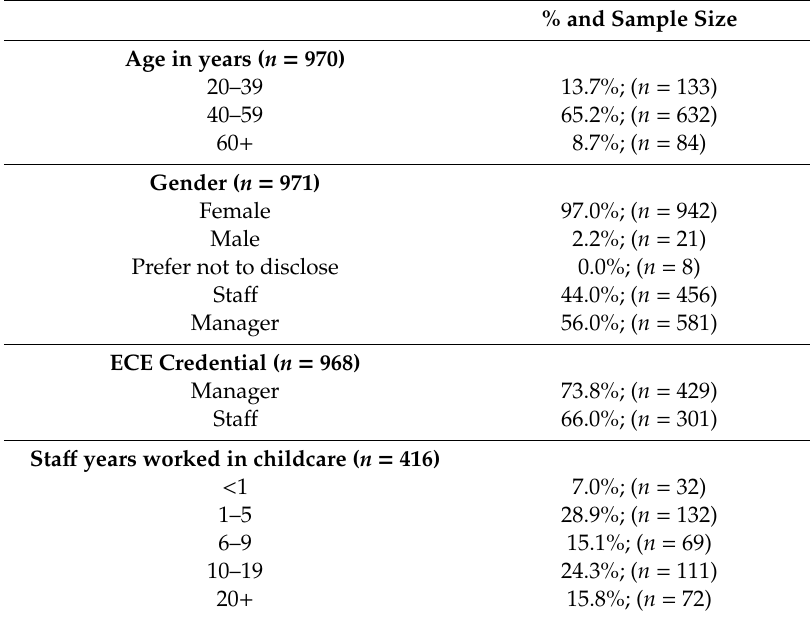
Table 1. Demographic characteristics of childcare facility respondents.